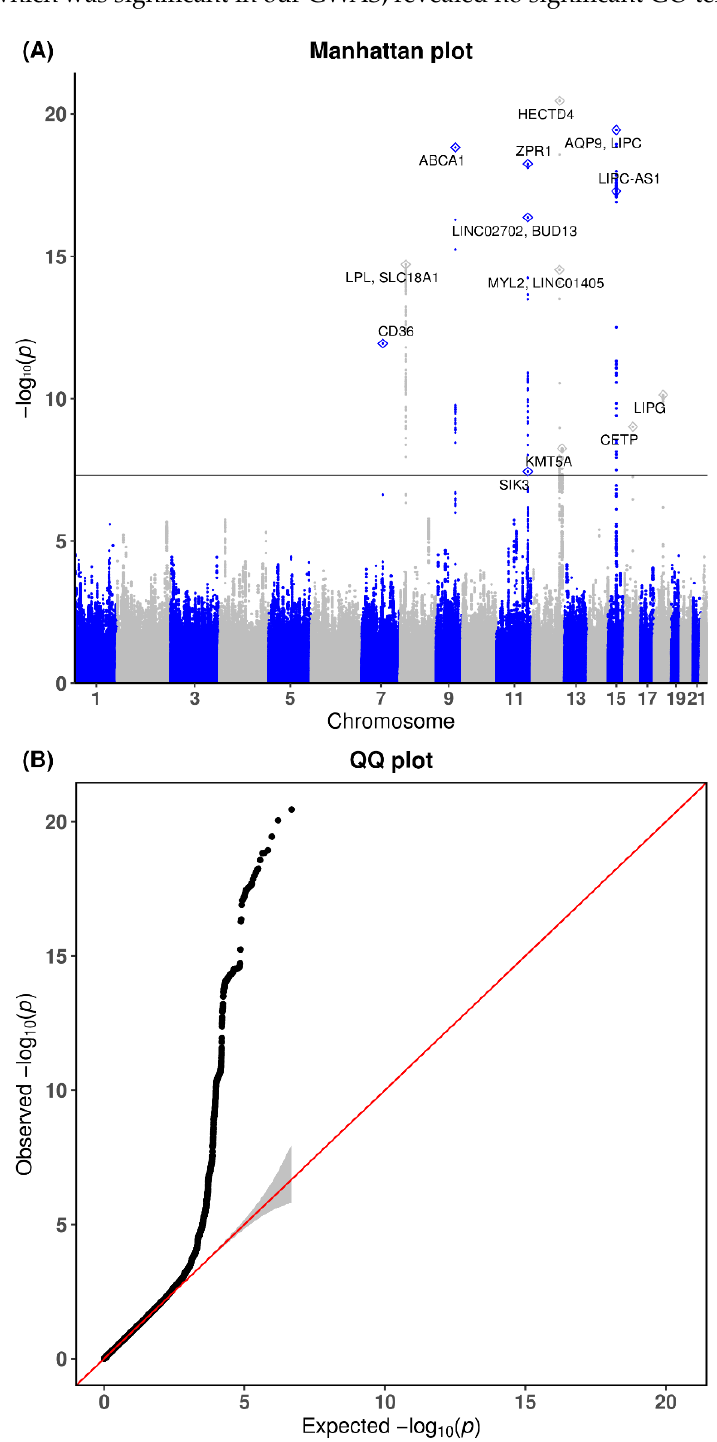
Figure 2. Genome-wide association of circulating ApoA1 by chromosome position, log10 p -value (Manhattan plot), and quantile–quantile plots for meta-analysis. ( A ) Manhattan plot of the p -values in the genome-wide association study meta-analysis for ApoA1. ( B ) Quantile-quantile (Q-Q) plot showing expected vs. observed values [ − log10( p )values]. The expected line is shown in red, and confidence bands are shown in